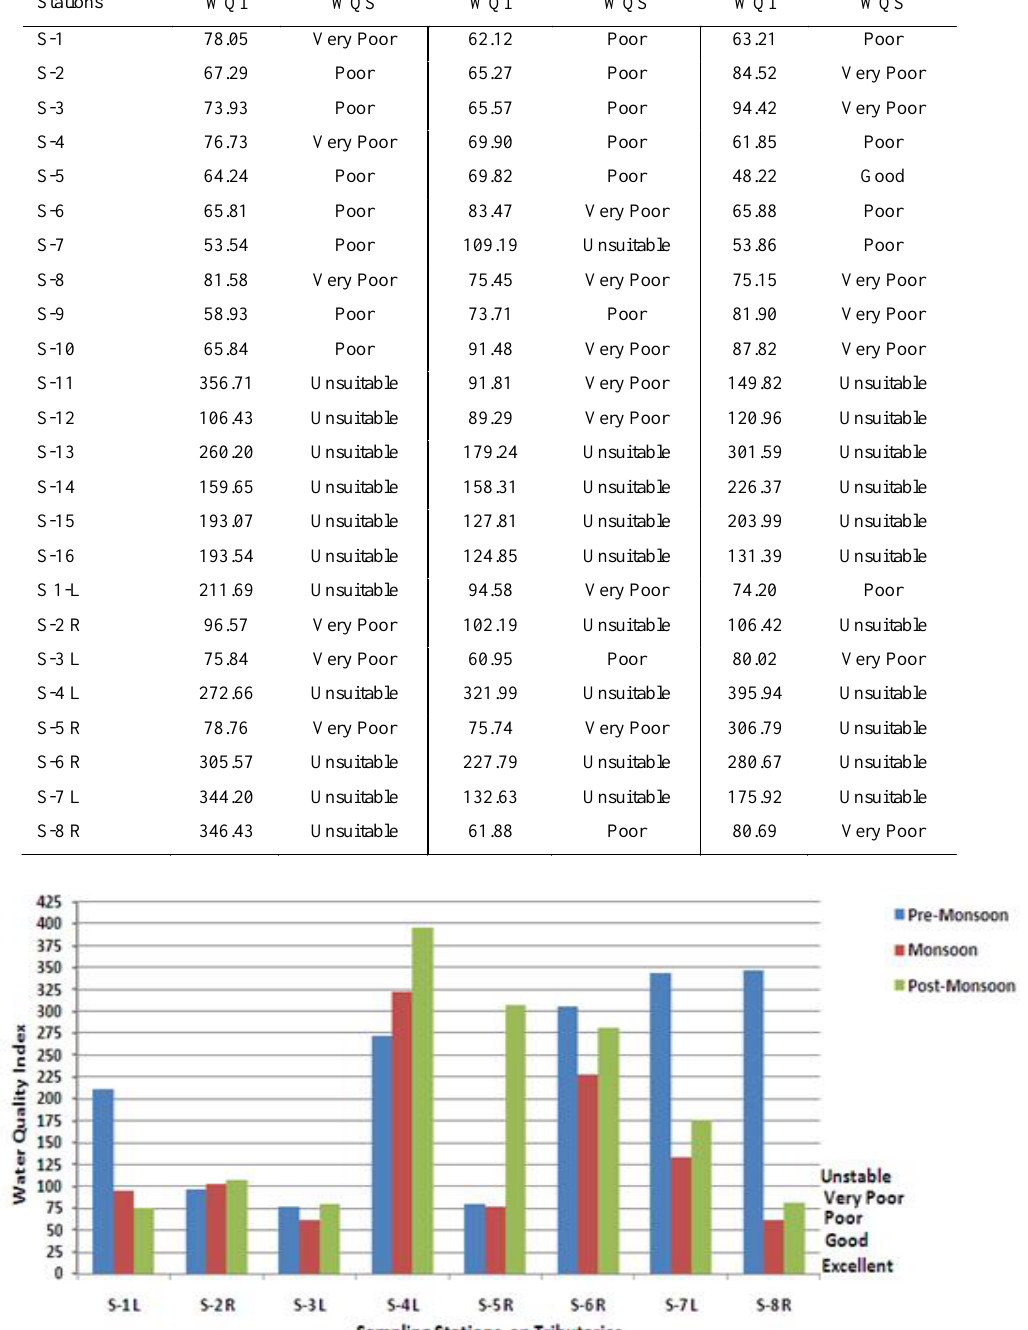
Table 8: Summary of WQI of the Vishwamitri river and its tributaries Sampling